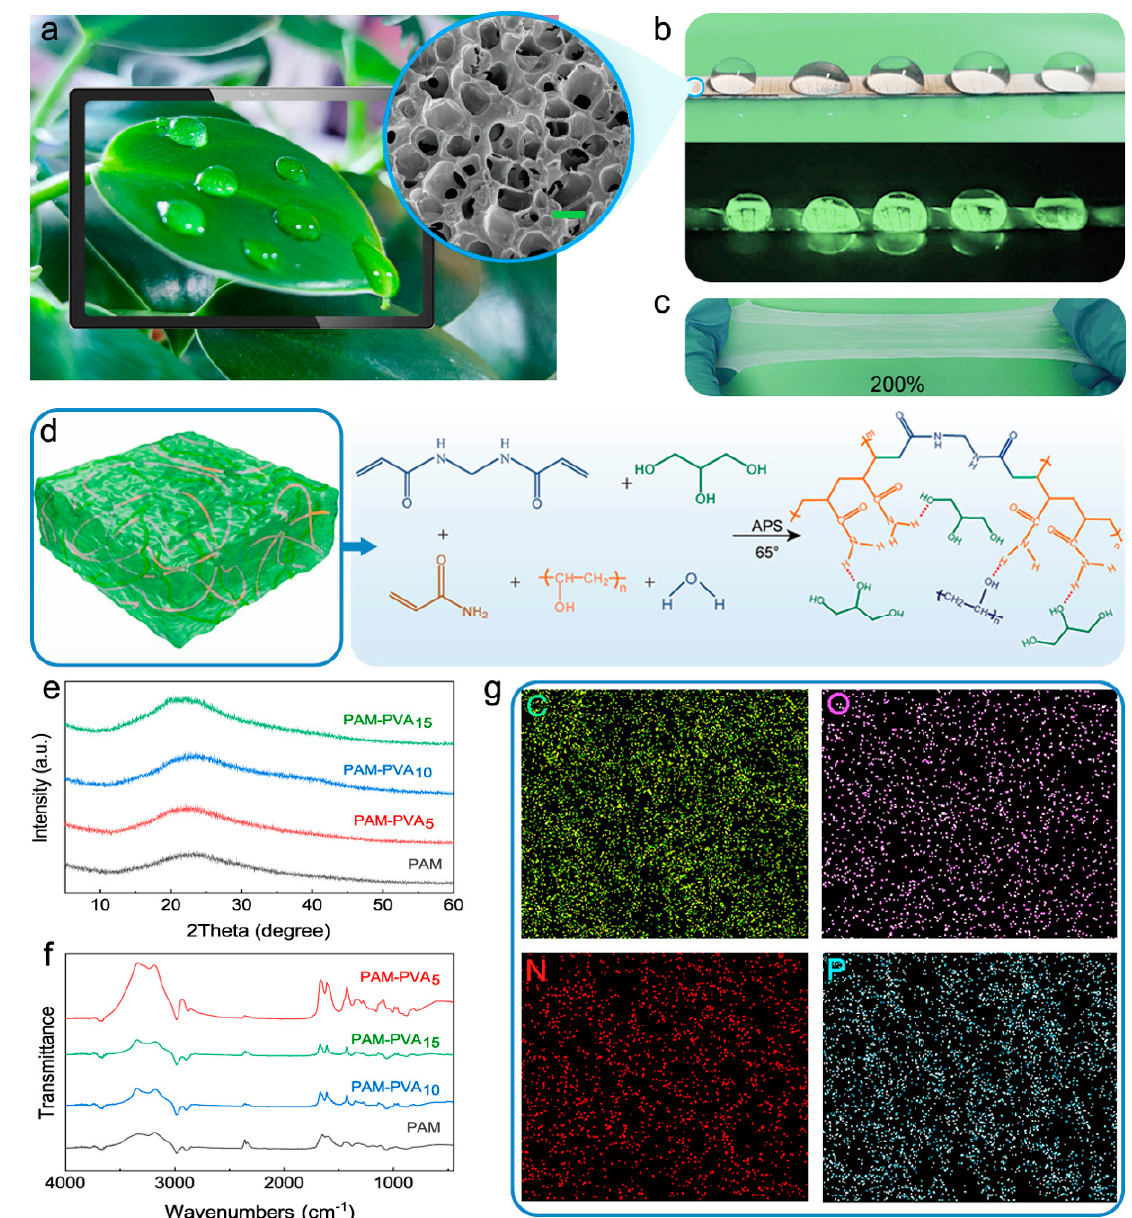
Figure 1. Schematic diagram and structural analysis of the PAM-PVA hydrogel. ( a ) The picture inspired by the response to mechanical stimuli of natural plants. ( b ) SEM of the hydrogel with a scale bar of 5 μ m used for bio-inspired electroluminescent skin. ( c ) The hydrogel as an electrode for a stretchable triboelectric nanogenerator. ( d ) Schematic illustration of the synthesized PAM-PVA hydrogel showing the dual cross-link network. ( e ) XRD patterns of the hydrogel with different contents. ( f ) FTIR spectra of PAM, PAM-PVA 5 , PAM-PVA 10 , and PAM-PVA 15 hydrogels. ( g ) EDX maps of the PAM-PVA 10 hydrogel.